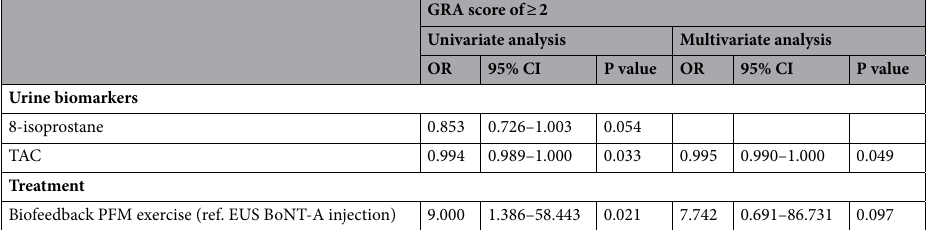
GRA score of ≥ 2 Univariate analysis Multivariate